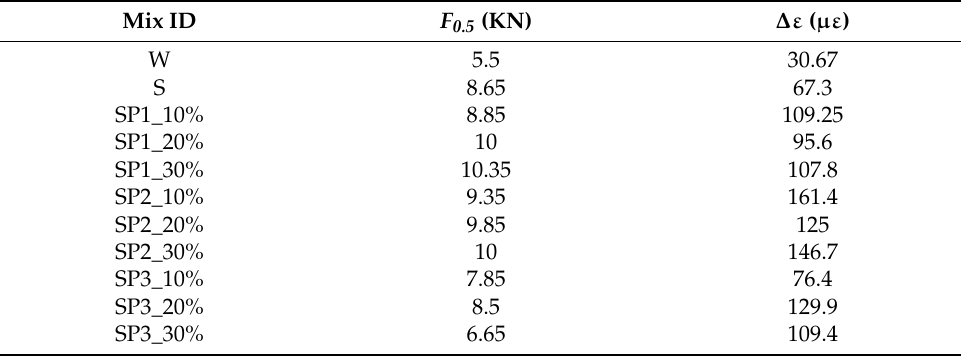
Figure 8. Comparison of flexural tests results. Table 5. Test data of upper limit load and flexural strain